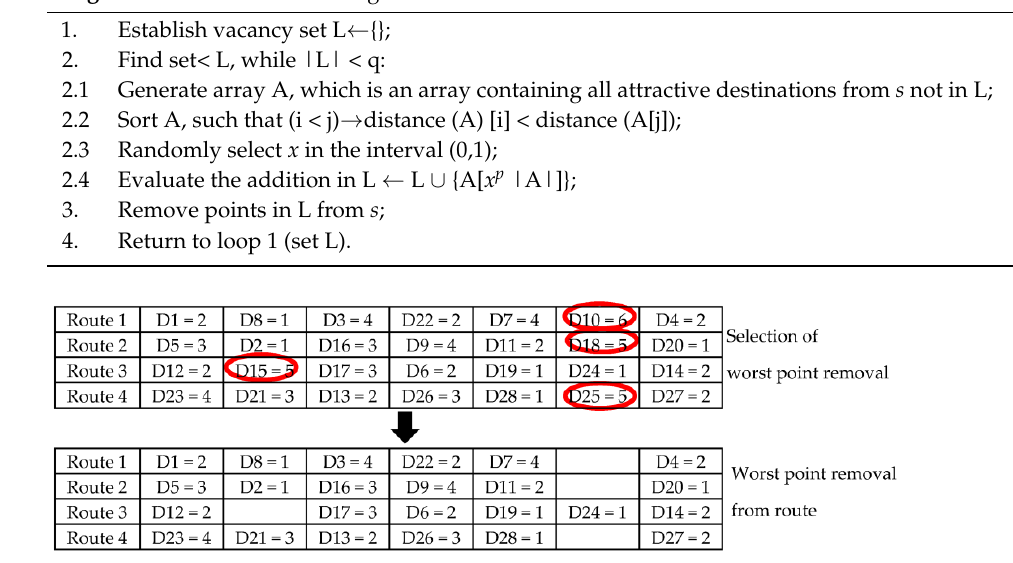
Figure 4. The worst point removal.